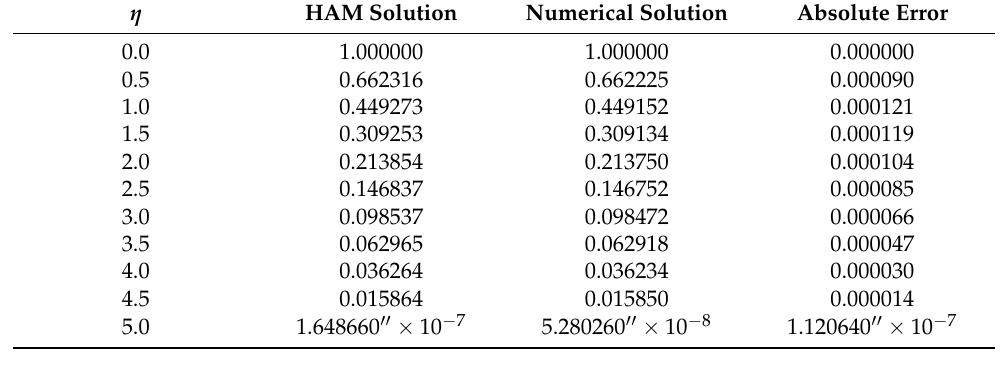
Table 4. Comparison table for HAM solution and numerical method for concentration field and their results.